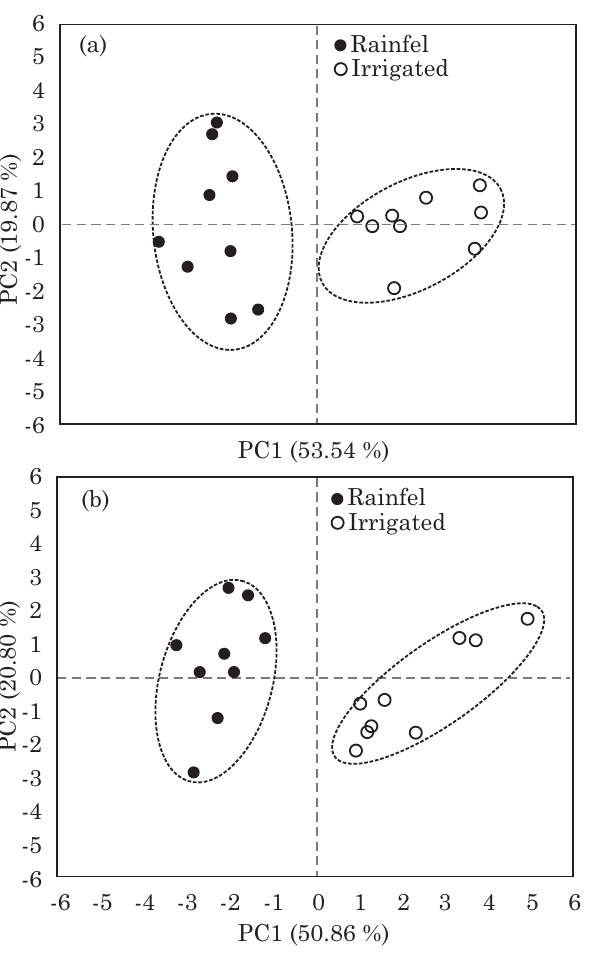
Figure 2. Ordination diagram derived from the principal component analysis of microbial and soil organic carbon under split P applications and irrigation regimes: (a) 0-5 cm, (b) 5-10